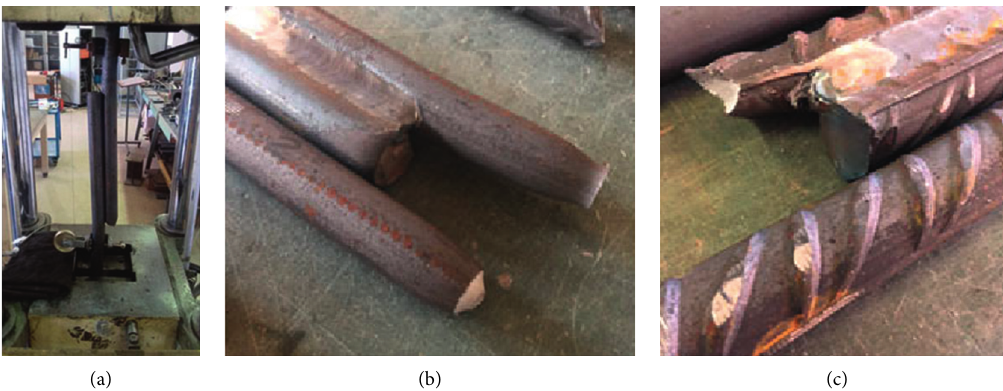
Figure 5: Experimental tests on lap joints (a) and example of failure in smooth (b) and ribbed bars (c) of large diameter. In case of ribbed bars, the lack of necking and the failure close to the HAZ is